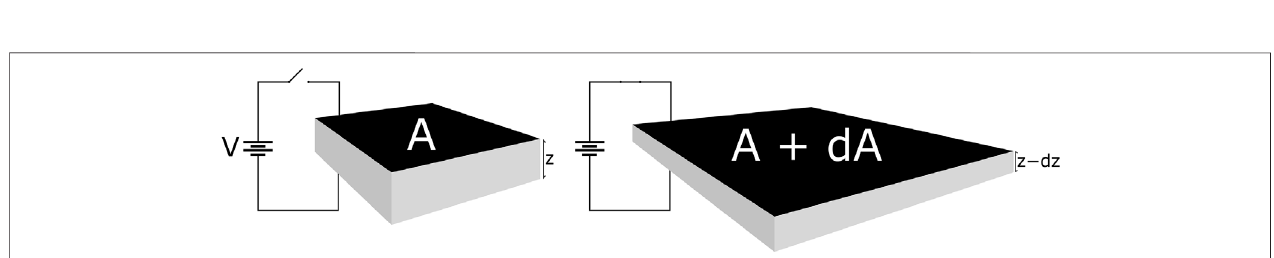
FIGURE 1 | Left: Basic structure of the podium (tube foot) of the common star fi sh, Asterias Rubens , showing the muscles used for contracting and deforming the ampulla and podium. Right: A star fi sh righting itself on the sea fl oor, with close-up of the leg showing many podia in actuation [photographs by Iain Anderson].